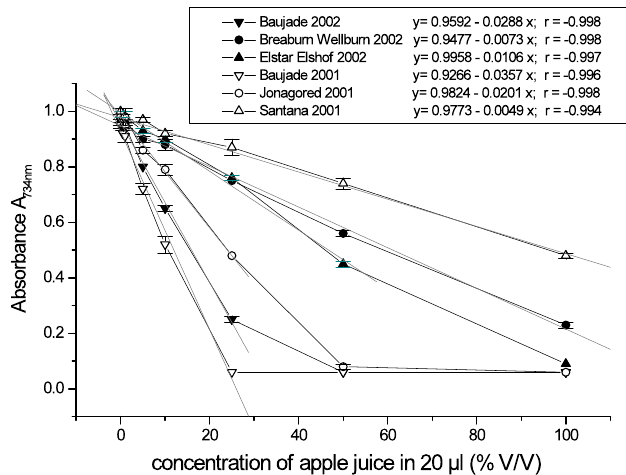
Fig. 1: Extent of reaction of ABTS-cation radicals with diluted apple juices. 20μl of the appropriate dilution (as indicated on the x-axis) of the